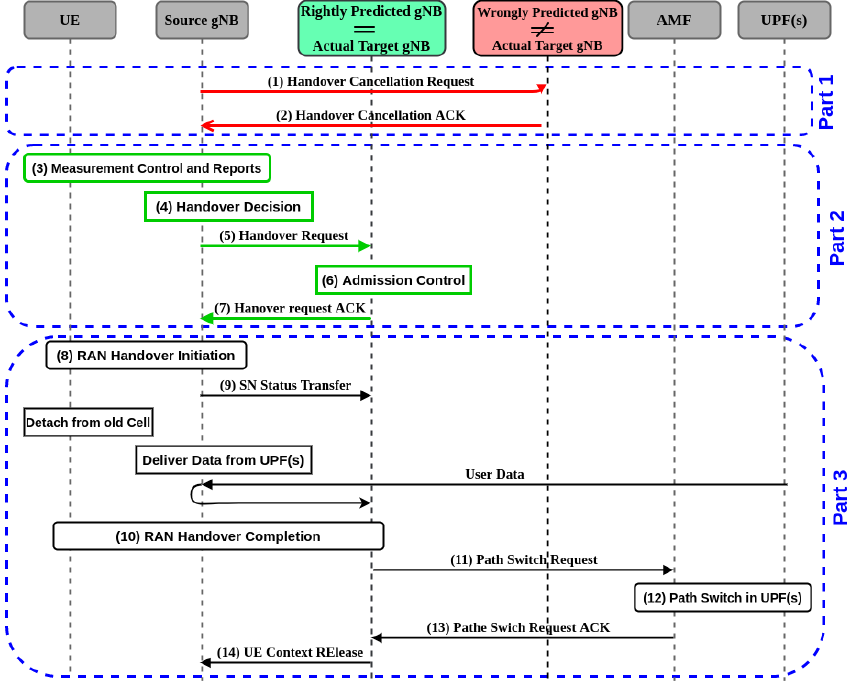
Figure 3. Intra-AMF-UPF handover signaling diagram. AMF and UPF in the 5G architecture refer to access and mobility management function (AMF) and user plane function (UPF).